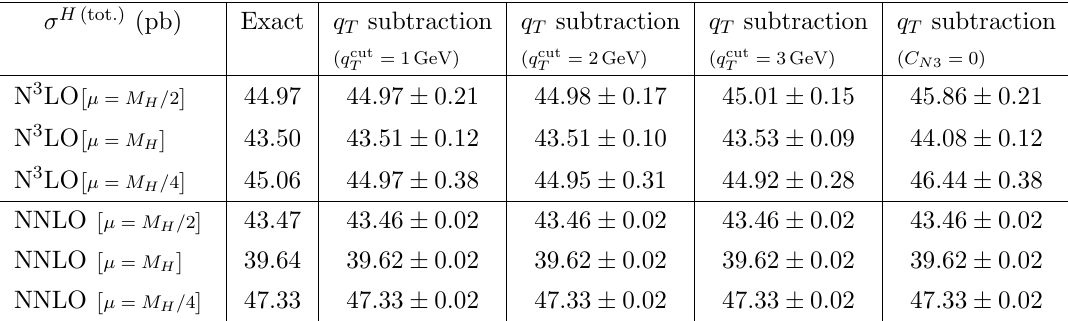
p Table 2 . The total cross section for Higgs boson production (cid:27) H (tot.) at the LHC ( s = 13 TeV). Results for NNLO and N 3 LO cross sections for three di(cid:11)erent scales (cid:22) = M H = 2 (central scale), (cid:22) = M H and (cid:22) = M H = 4. The column ‘‘Exact’’ contains the results of ref. [15] computed with the numerical code of ref. [77] as detailed in the text. The results with the q T subtraction method are obtained using three di(cid:11)erent values of q cut (1,2 and 3 GeV), and their uncertainties are calculated T with the customary propagation of statistical errors. The last column shows (cid:27) H (tot.) obtained with the q T subtraction method and using C N 3 = 0 at N 3 LO. The values of (cid:27) H (tot.) reported in this table are shown in (cid:12)gure 3. The NNLO cross sections computed with the q T subtraction method are obtained using q cut = 1 GeV, i.e. the variation of this parameter in the N 3 LO cross section T